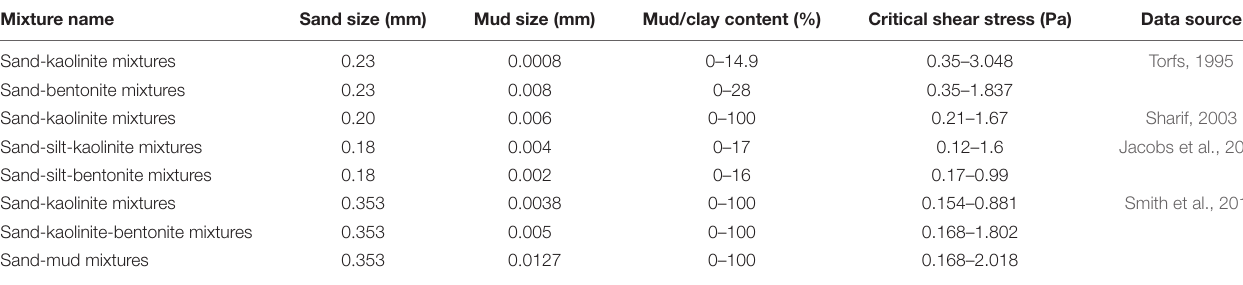
TABLE 1 | Summary of collected experimental data of sand-mud mixtures and data